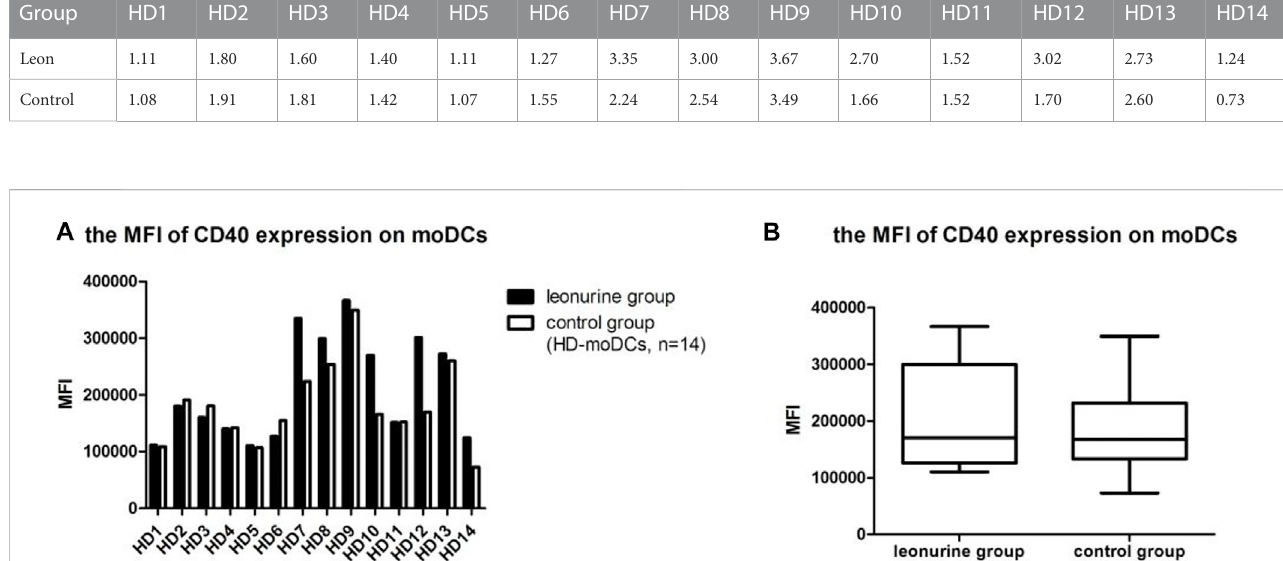
TABLE 3 The MFI of CD40 expression on moDCs (×105) (HD-moDCs, n = 14). Group